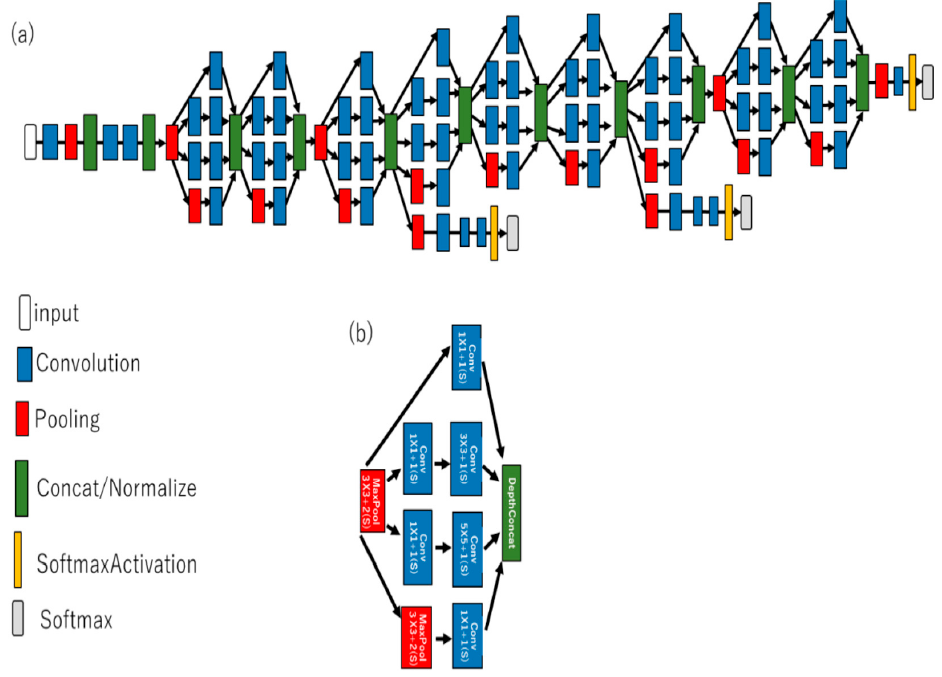
Figure 2. The CNN model in GoogLeNet consisting of a 22-layer-deep neural network. ( a ) Imple- mented with a novel element dubbed an Inception module. Sub-networks consisting of pooling, convolution, softmaxActivation, and softmax named by auxiliary loss is added in this main line to prevent the vanishing gradient problem. ( b ) Inception module: a module intended to have high expressive power while reducing parameters, by internally creating paths of various sizes and per- forming quantification by reducing the dimension of each path ( Front. Bioeng. Biotechnol. 2019 , 7 , 65. [57]).